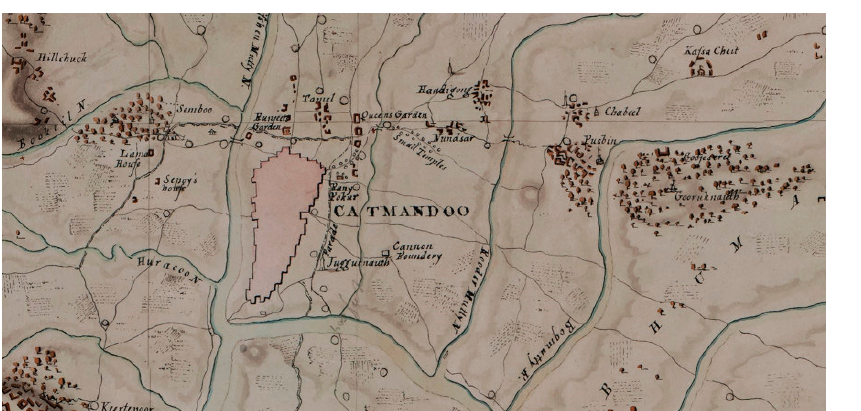
Figure 2. Snap of 1”:4 miles topographic map [16].